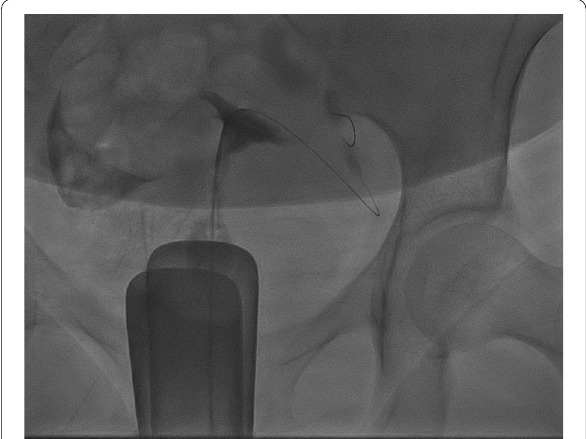
Fig. 3 Twenty‑five‑year‑old patient with secondary infertility unilateral left proximal tubal obstructions were recanalized by the wire